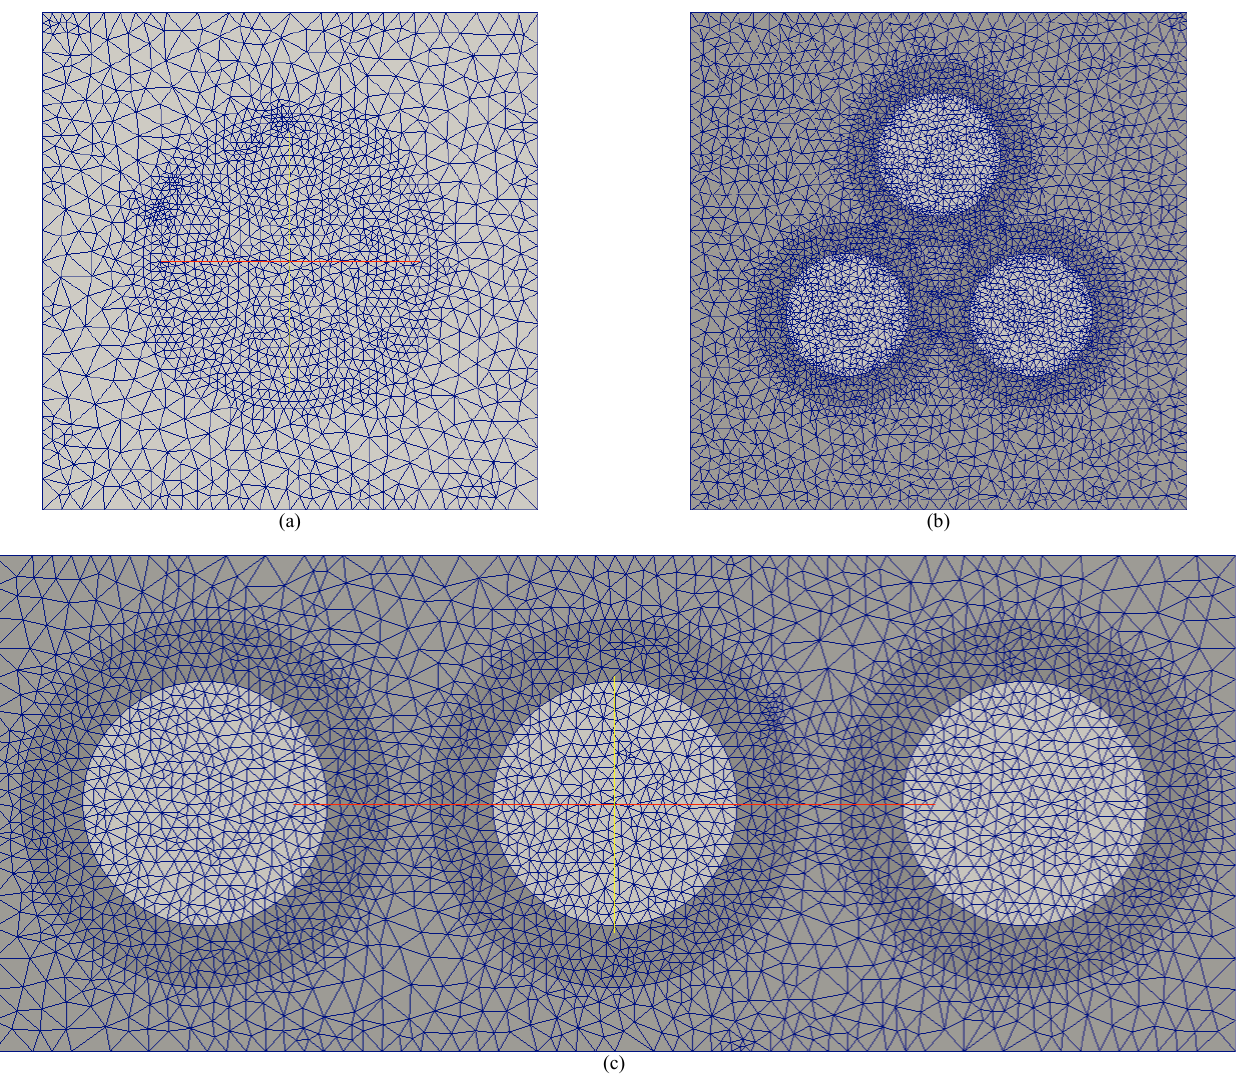
Fig. 9. Meshes generated with aCute software for (a) stand alone cable, (b) compact triangular placement of three cables, (c) linear placement of of three cables.